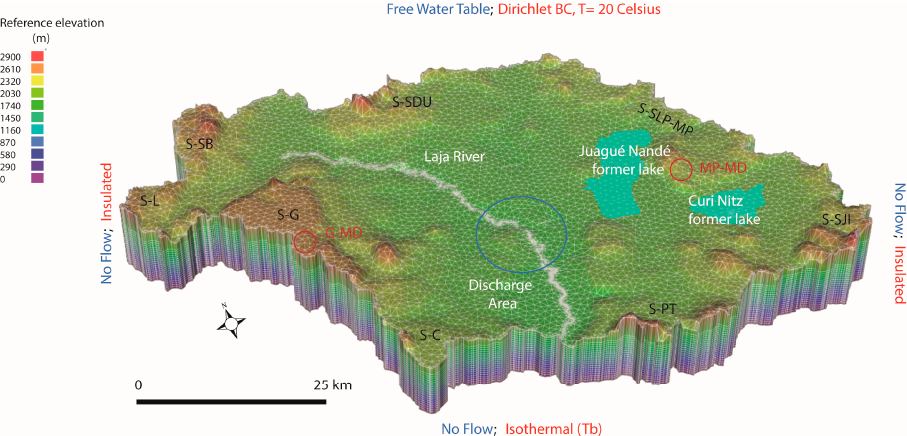
Figure 2. Domain of the Independence Basin showing the elevation of mountain massifs and the course of the La Laja River that runs northwest-to-south. Several features of the flow system are shown, including the main discharge area in the central part of the basin (blue circle) associated with saline soils, phreatophytes, and thermal springs. Boundary conditions for flow (blue) and heat (red) are indicated. The sites of two ancient lakes, Juagué Nandé and Curi Nitz, appear in cyan. The main sierras that delimit the IB are Guanajuato (S-G), Santa Bárbara (S-SB), San Diego de la Unión (S-SDU), San Luis de la Paz-Mineral de Pozos (S-SLP-MP), Dr. Mora (S-DMR), San Jos é Iturbide (S-SJI), Picachos-T á mbula (S-PT), and Codornices (S-C). Two important mining districts are circled in red: Guanajuato (MD-G) and Mineral de Pozos (MD-MP). Vertical exaggeration of the scale is